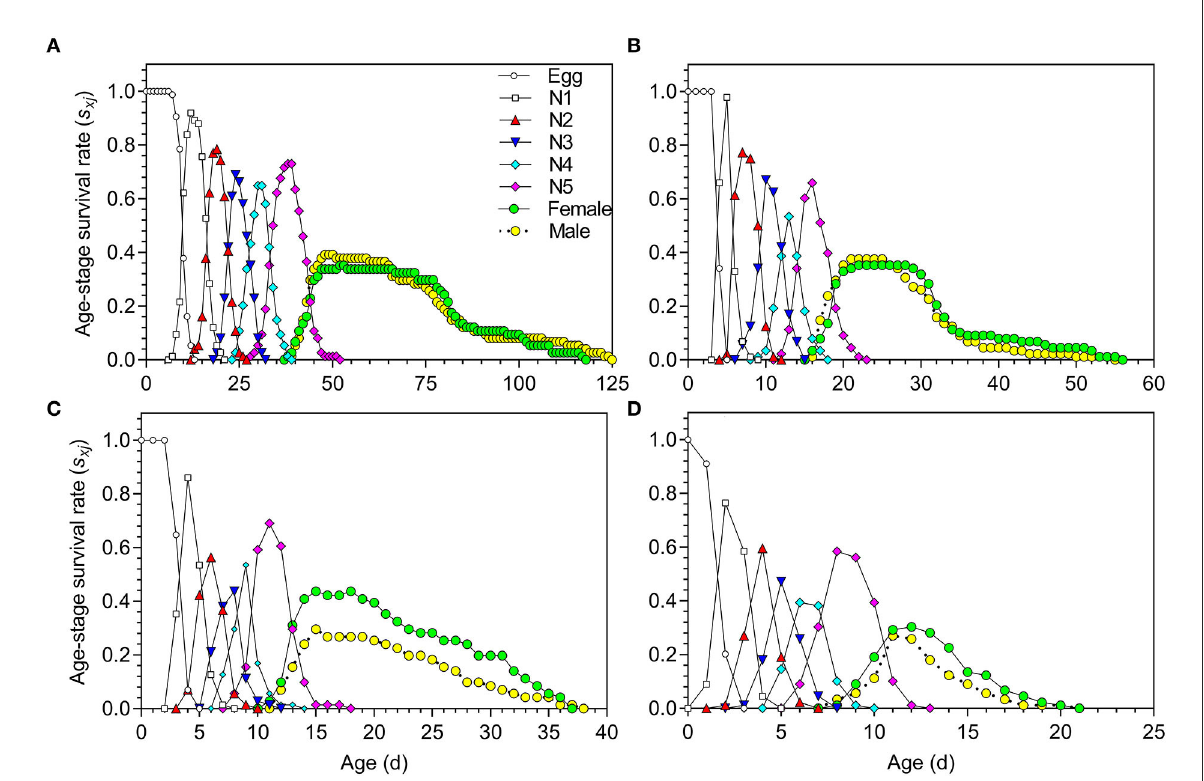
FIGURE1 Age-stage survival rate ( s xj ) of Orius strigicollis fed on Frankliniella occidentalis under 18.5 ◦ C (A) , 23.5 ◦ C (B) , 27 ◦ C (C) , and 33 ◦ C (D)